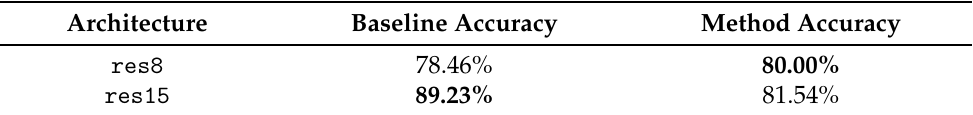
Table 8. Resulting test accuracy after the pre-training on the surrogate samples. The best result for each architecture is